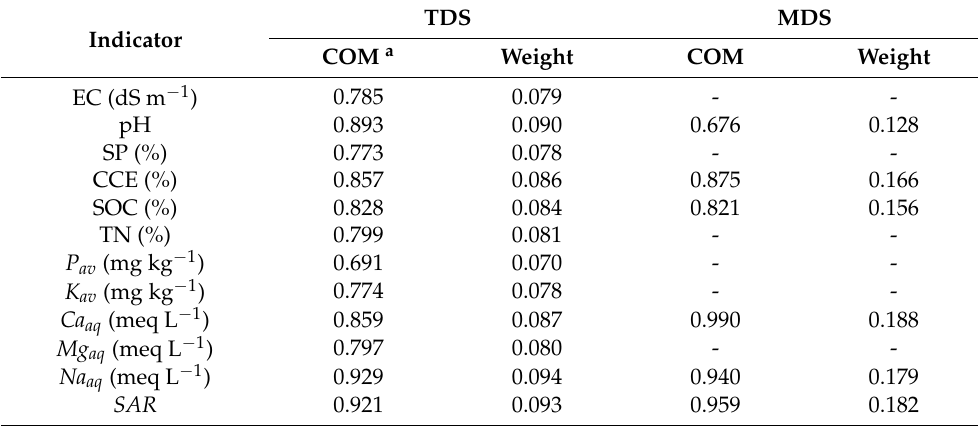
Table 2. Communality and weight of SQIs in the TDS and MDS